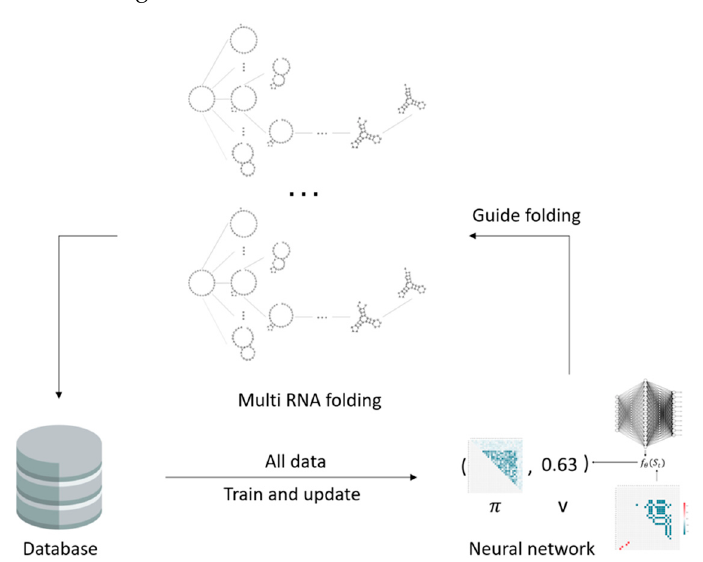
Figure 12. Diagram of multi-RNA molecular folding path